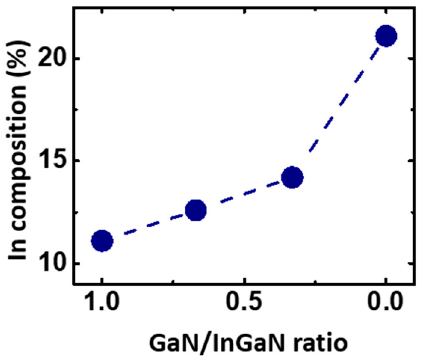
Figure 3. Effective In composition (measured by XRD) with decreasing hydrogen pulse time (resulting in decreasing GaN thickness in the SL). The samples were gown at 840 °C with a Cp 2 Mg flow of 36 nmol/min. The surface morphology can be seen in Figure 2 with GaN/InGaN ratios of 1, 0.67, 0.33, and 0, corresponding to ( a – d ), respectively.